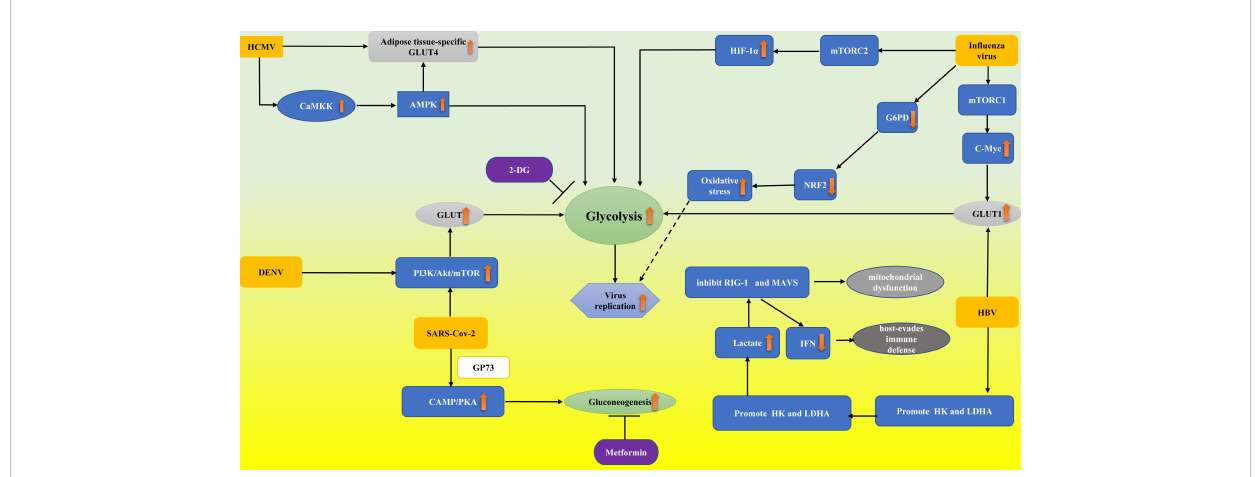
FIGURE 1 Abnormal glucose metabolism in virus-associated sepsis. In fl uenza virus decreased the expression and activity of G6PD and thus downregulated the expression of NRF2, which regulates the gene network of the antioxidant response. Finally, the oxidative stress and virus replication were aggravated. In fl uenza virus proteins promote glycolysis by stimulating the mTORC1 and mTORC2 pathways by upregulating GLUT1 and HIF-1 a expression, respectively. DENV activated the PI3K/Akt/mTOR pathway to upregulate GLUT expression, thus enhancing glycolysis. HCMV resulted in AMPK activation through CaMKK. AMPK activation resulted in glycolytic activation to provide energy and facilitate virus replication. HCMV infection can upregulate GLUT4, which increases glucose uptake. Activated AMPK in turn stimulates glycolysis by GLUT4. HBV achieves glycolytic metabolic recombination by increasing GLUT1 expression. HBV regulates HK activity, and LDHA stimulates lactic acid production, thereby inhibiting RIG-I interaction with MAVS and leading to immune escape by regulating IFN production. SARS-CoV-2 activated the PI3K/Akt/mTOR pathway and led to the release of GP73, which stimulated liver gluconogenesis to enhance fasting glucose through cAMP/PKA. 2-DG and Metformin inhibit viral replication through the mechanisms of suppressing glycolysis and gluconeogenesis, respectively. PI3K/Akt/mTOR pathway, phosphatidylinositide 3-kinases/protein kinase B/mammalian target of rapamycin; cAMP/PKA, cyclic adenosine monophosphate/protein kinase A; CaMKK, calcium/calmodulin dependent kinase; NRF2, nuclear factor erythroid 2-related factor 2; G6PD, glucose-6-phosphate dehydrogenase; 2-DG, 2-deoxy-D-glucose; MAVS, mitochondrial antiviral signaling; HK, hexokinase; RIG-I, retinoic acid-inducing gene I; HIF-1 a , hypoxia-inducible factor-1 a ; mTORC1, rapamycin complex 1; GP73, a type II transmembrane Golgi protein; GLUT4, adipose tissue-speci fi c glucose transporter type 4. The upward orange arrow means upregulation.The downward orange arrow means